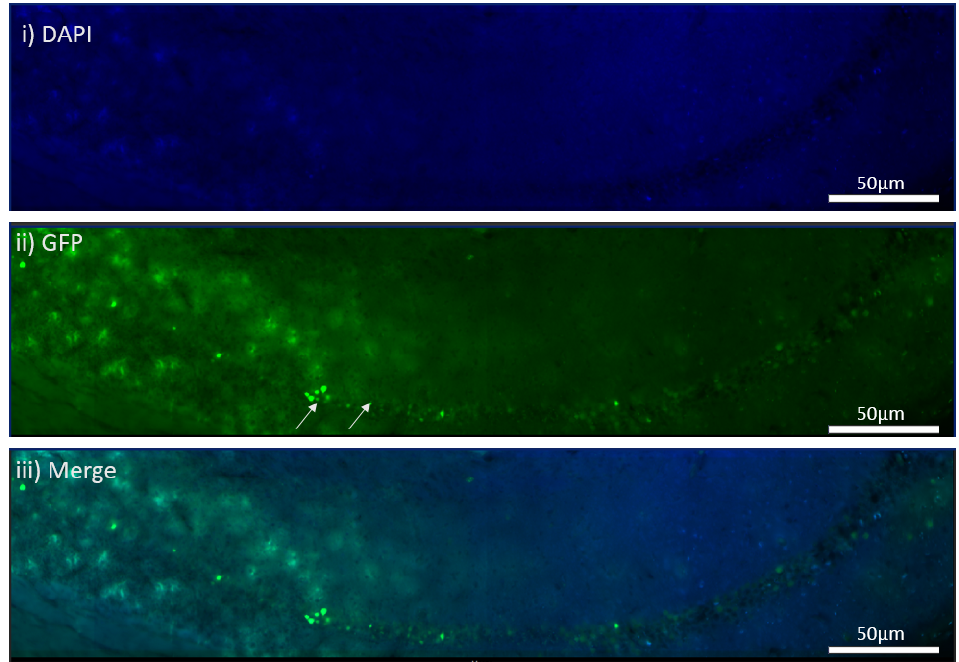
Figure 5. In vivo virus transduction of the hippocampal CA1 neurons in MEN1 floxed mice. ( i ) DAPI for nuclear staining; ( ii ) GFP expression in the CA1 neurons and the ectopic expression in the vicinity of the CA1 region as pointed by the arrows; ( iii ) merge showing the overlap between DAPI and GFP.